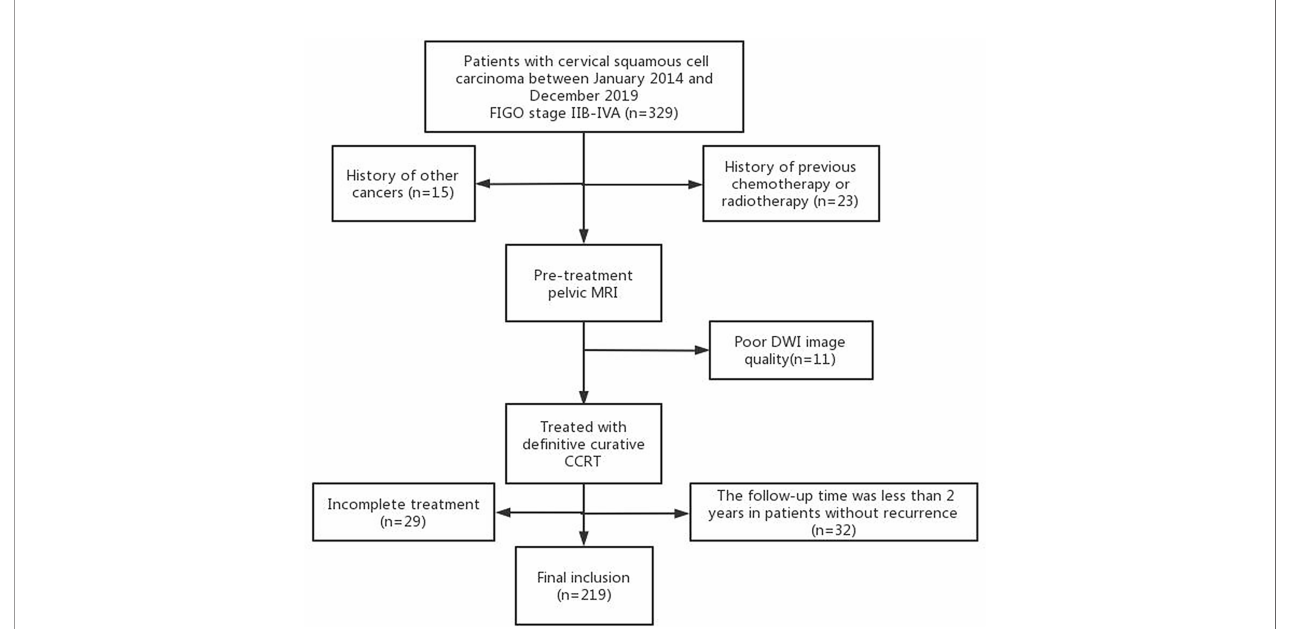
FIGURE 1 | The fl owchart of the study